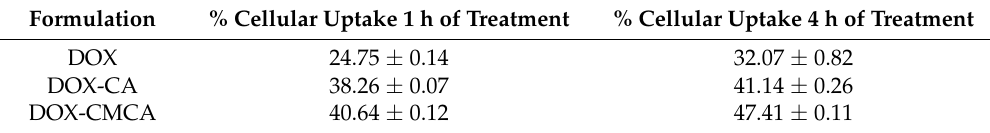
Table 5. Cellular uptake for DOX 5 µM, DOX (5 µM)–CA NPs and DOX (5 µM)–CMCA NPs after 1 h and 4 h of treatment.